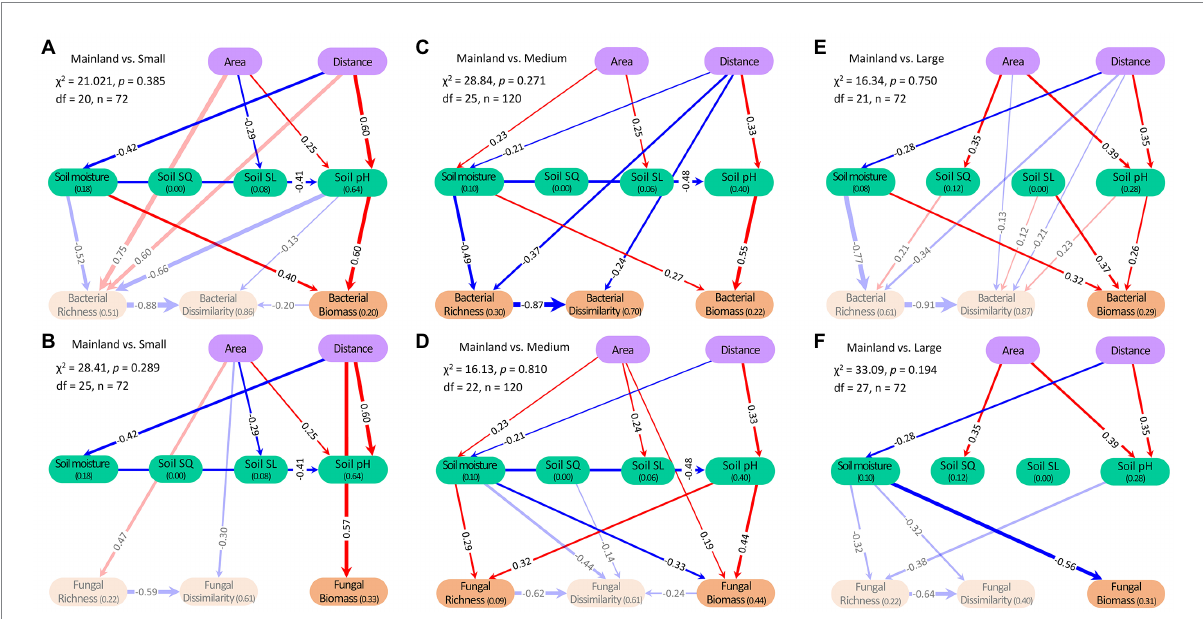
FIGURE 4 Structural equation model (SEM) for the response ratio of soil bacterial and fungal biomass, richness, and dissimilarity under small subdivision (A,B) , medium subdivision (C,D) , and large subdivision (E,F) . Soil SQ, soil substrate quantity; Soil SL, soil substrate quality. Arrows indicate significant ( p ≤ 0.05) effects. Values associated with arrows represent standardized path coefficients; pathways without significant effects ( p > 0.05) are not shown. Values associated with response variables in brackets indicate the proportion of variation (R 2 ) explained by relationships with other variables. The variables with light shade in the SEM indicate they are not significantly altered ( p > 0.05) by habitat